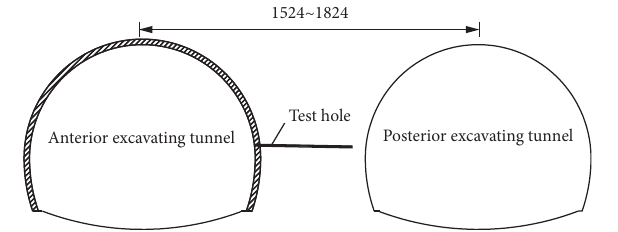
Figure 5: Profile of ultrasonic test hole (unit: